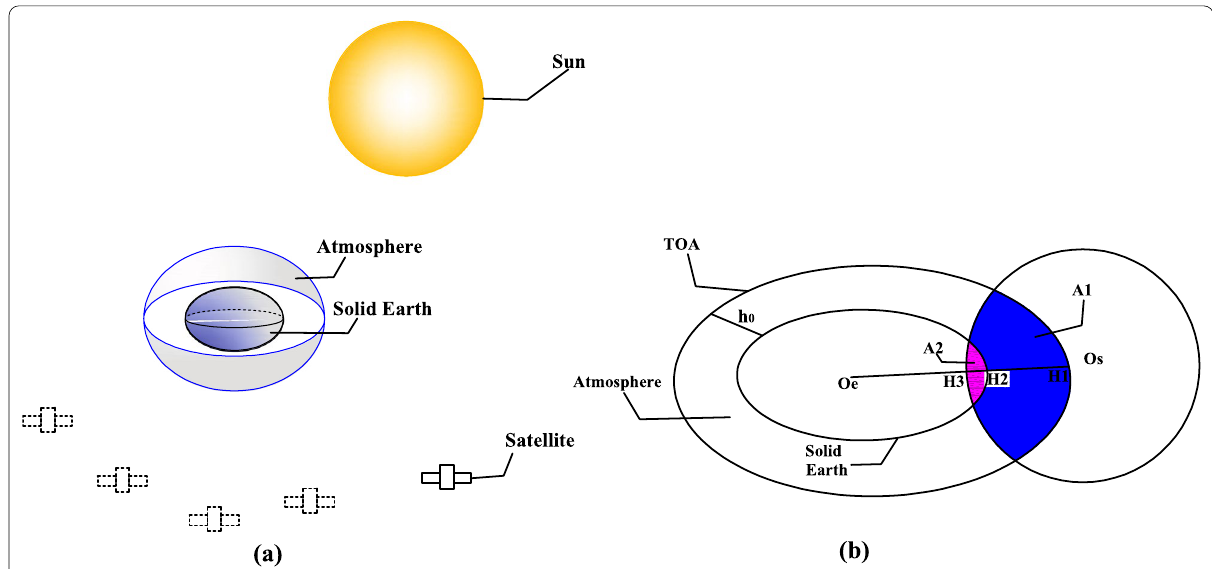
Fig. 4 a Different situations for the positional relationship between the Sun, the Earth, and the atmosphere; b situation when the solid Earth and the atmosphere partially occult the solar disk. A1 and A2 are the area of the Sun occulted by the atmosphere and solid Earth. Oe is the center of the Earth’s image, and Os is the center of the Sun’s image. H1 and H2 are the upper and lower boundaries for the overlapping part between the Sun’s image and the atmosphere’s image; H2 and H3 are the upper and lower boundaries for the overlapping part between the Sun’s image and the solid Earth’s